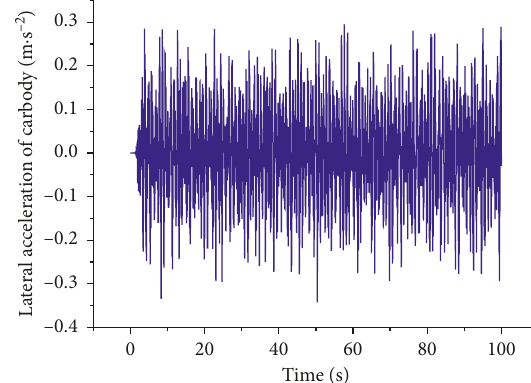
Figure 5: Car body lateral acceleration in the time